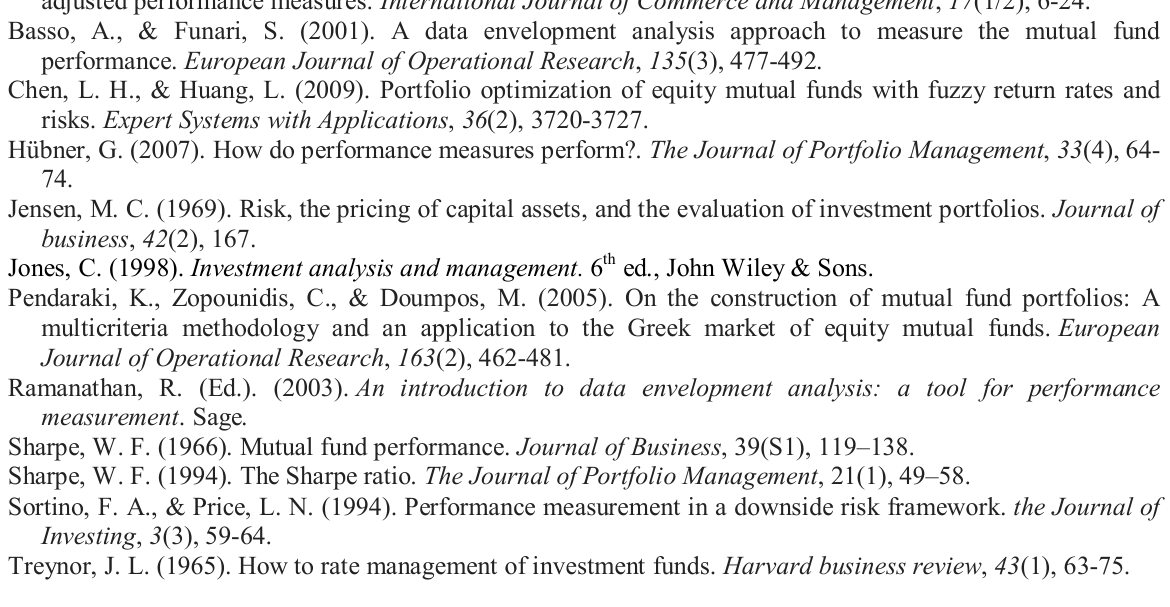
F-statistic Prob(F) Durbin-Watson R-squared A-R-squared Sum